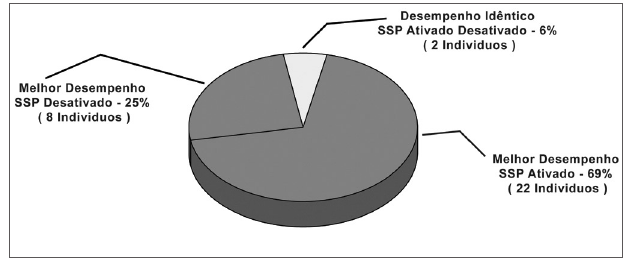
Figura 1. Desempenho dos indivíduos avaliados quanto à relação sinal/ruído. SSP: Speech Sensitive